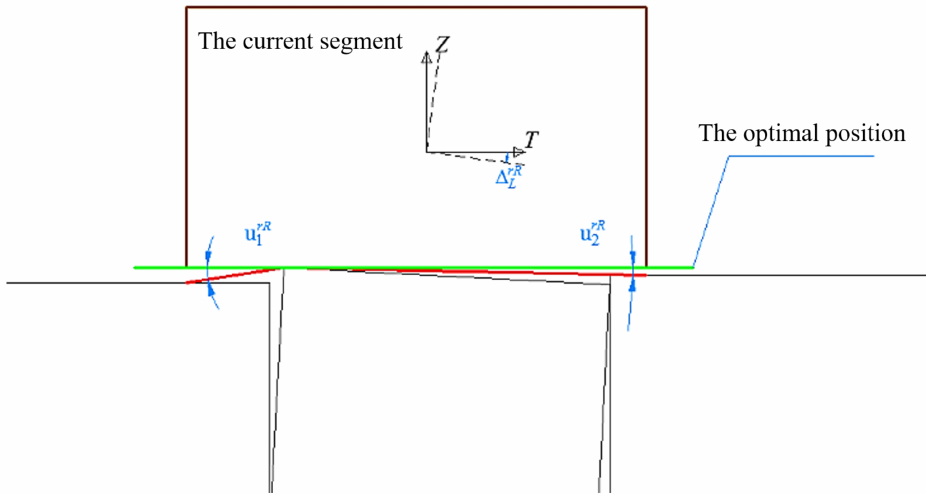
Figure 7. Schematic diagram of the ring-seam lamination